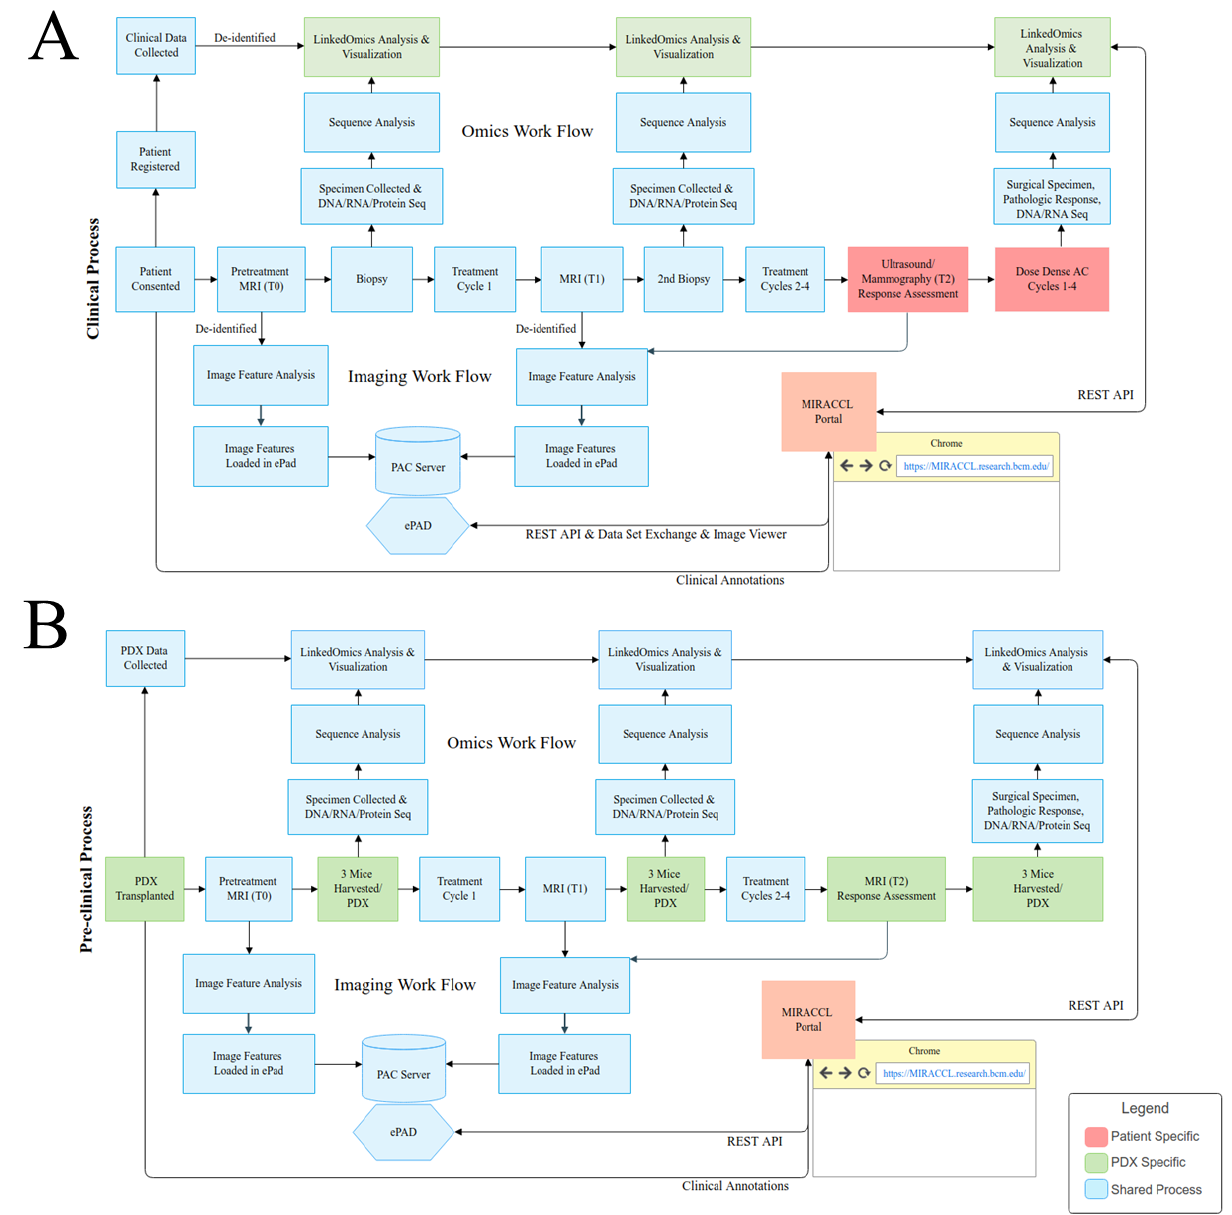
Figure 3. ( A ) Clinical workflow associated with a co-clinical trial. ( B ) Pre-clinical workflow associated with a co-clinical trial. The study workflows are diagramed centrally within each figure with specimen collection timepoints for omics generation shown above the study workflow and imaging collection timepoints shown below the workflow. Workflow steps shown in blue are standard across both the patient and PDX cohort while patient specific steps are shown in salmon and PDX specific steps in green.